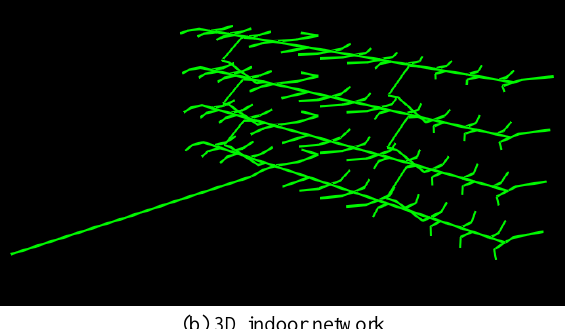
Figure 1 3D indoor path modelling